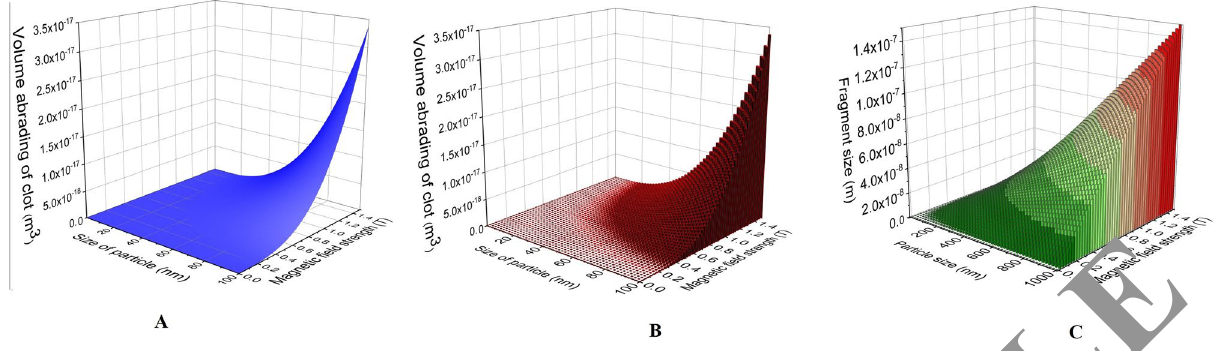
Figure 10. ( A ) The relationship between the applied force on a nanoparticle and the magnetic field strength and particle size. ( B ) The relationship between the removal volume of the clot by a single nanoparticle and the magnetic field strength. ( C ) The relationship between the size of fragments and the magnetic field strength and particle